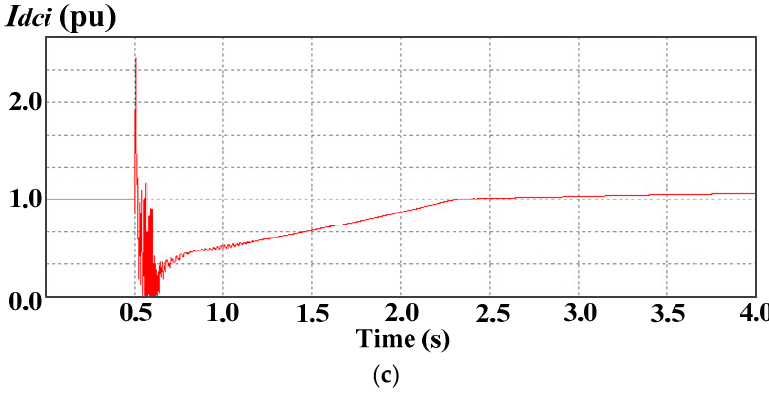
Figure 14. Inverter DC current for a three-phase ground fault: ( a ) PSCAD, proposed, and conven- tional; ( b ) CDC4T and CDC6T; ( c ) CDC7T. Table 8. Summary of the maximum DC voltages and currents at the inverter for the three ‐ phase line ‐ to ‐ ground fault.